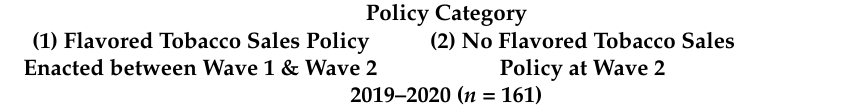
Table 3. Prevalence of ENDS availability in Bay Area retail stores by flavored tobacco sales